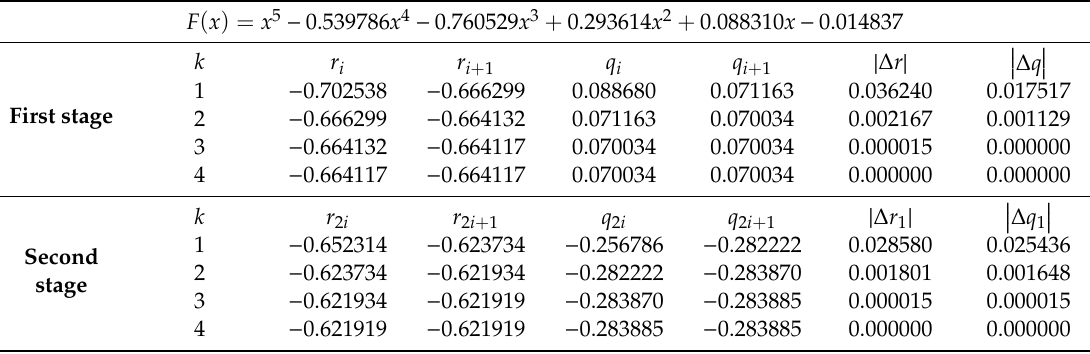
Figure 2. Histograms of the iteration numbers required to converge, with the adaptive initial method and the static initial method, respectively: ( a ) n1, ( b ) n2, ( c ) n3, and ( d ) n4. Table 5. The detail steps to extract the roots of F ( x ) using the proposed method.